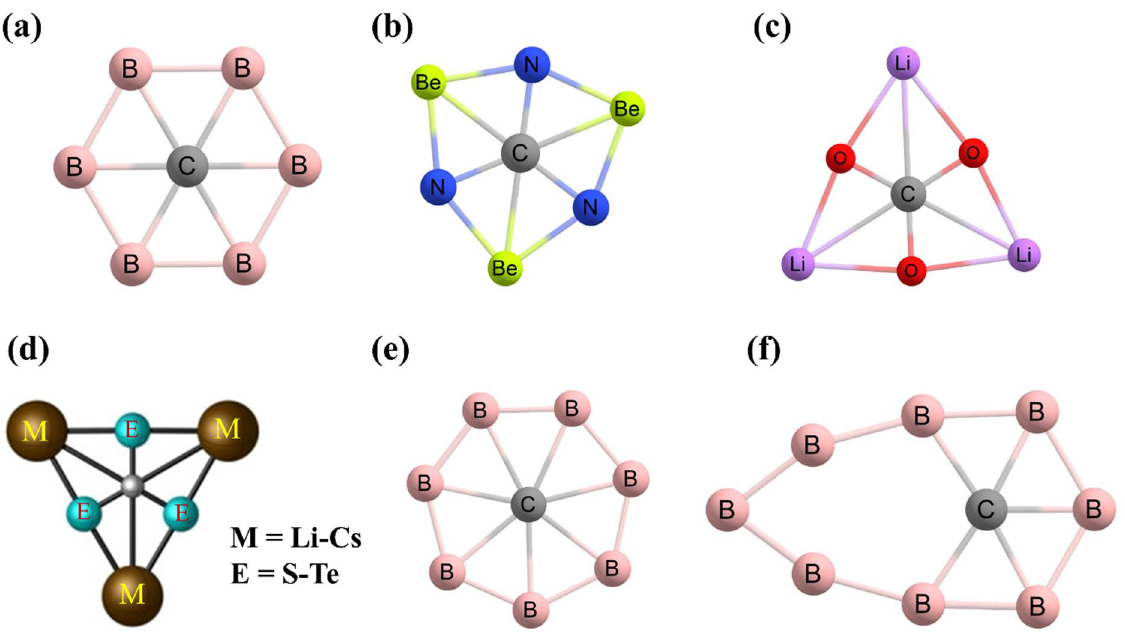
Figure 29. Local minimum structures of ( a ) CB 62− and ( b ) CN 3 Be 3+ clusters with a phC. Global minimum structures of ( c ) CO 3 Li 3+ and ( d ) CE 3 M 3+ (E = S–Te, and M = Li–Cs) clusters. Local minimum structures of ( e ) CB 7− cluster with planar heptacoordinate carbon. Minimum energy structure of ( f ) CB 8 cluster with a ppC.